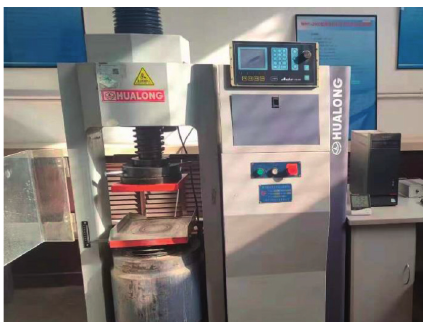
Figure 5: 2000kN press machine.